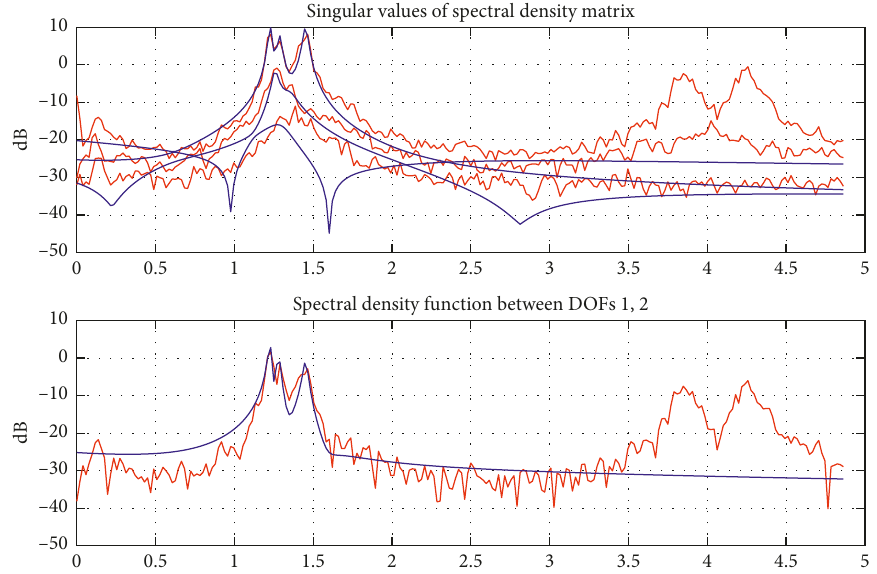
Figure 4: Estimated empirical density functions of the Heritage Court Tower case (red) and synthesized density functions (blue). Top plot shows the singular values of the spectral density matrix, S ( ω ) , and the bottom plot shows the cross spectral density function, g ( f ) � G ( 1 , 2 )( f ) , between the first and second y 12